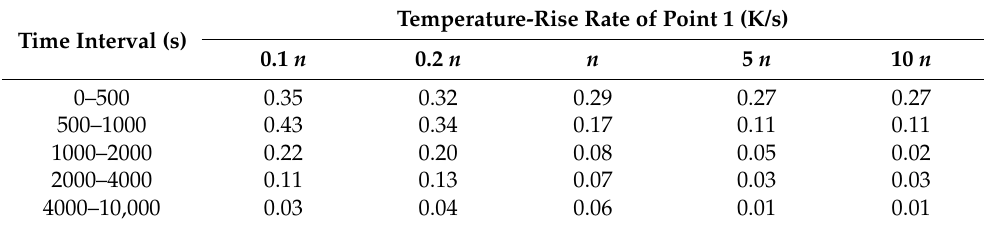
Table 9. Temperature-rise rate with different expansion rates at different times.